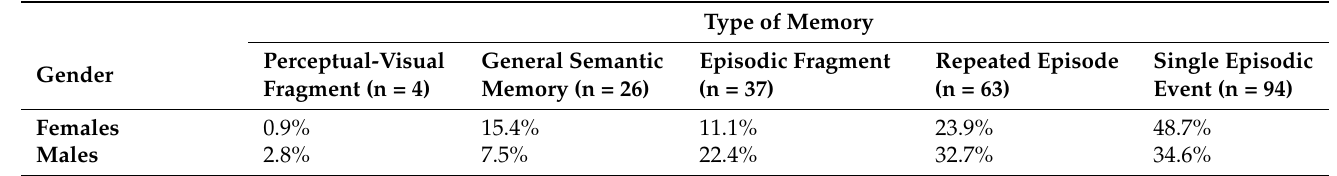
Table 7. Frequencies of the different types of memories reported by females and males in epoch 2 (the different types of memory reported are